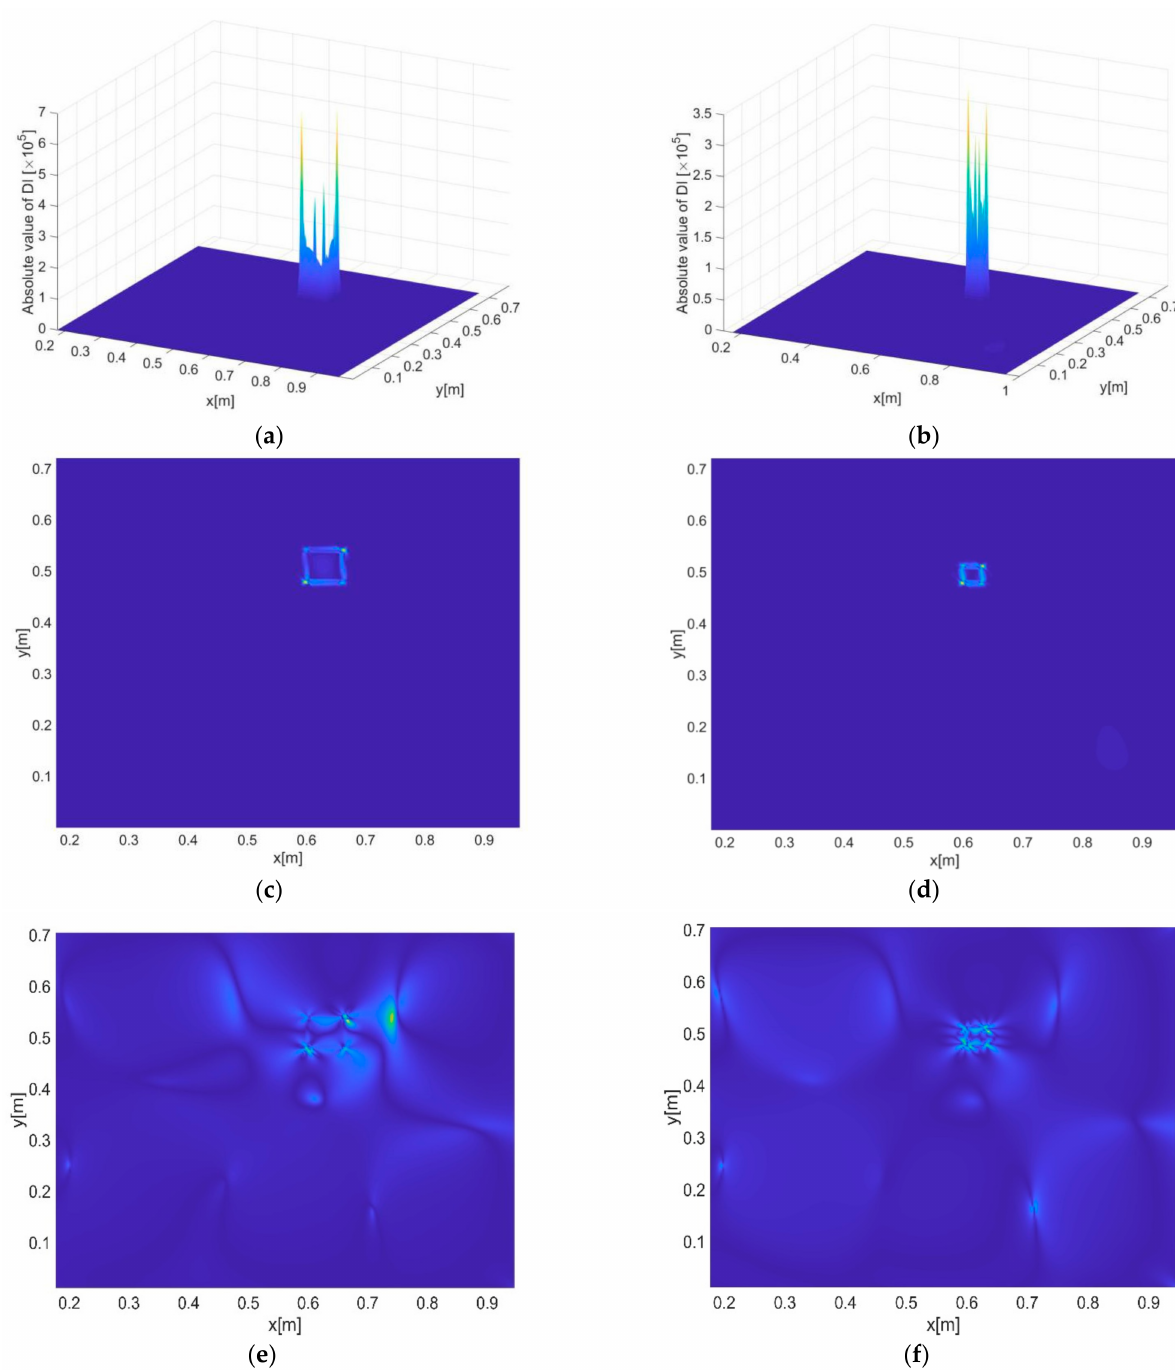
Figure 8. Constructed damage indexes (Dis) of the iFEM-PE method across the inspection region, corresponding to ( a , b ) damage scenario A, and ( c , d ) damage scenario B, respectively. ( a , c ) and ( b , d ) are the two- and three-dimensional views of DI, respectively. ( e , f ) present the damage identification results of scenario A and B, respectively, by using the method developed in